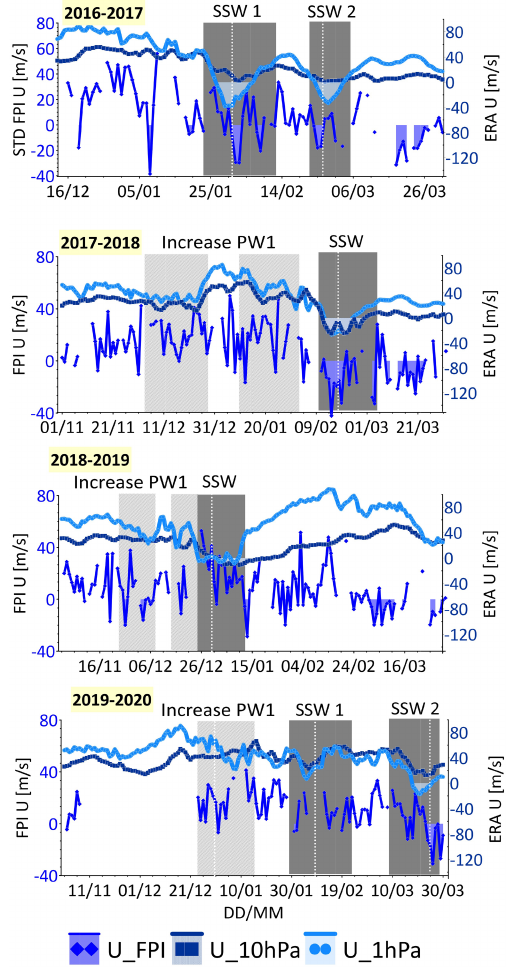
Figure 15. FPI-measured 557.7nm zonal wind (blue line), zonal mean zonal wind by ERA 5 at 10hPa (dark blue line) and at 1hPa (light blue line), the PW1 amplitude increase period (light grey rect- angle), the SSW periods (grey rectangle), and the day of the SSW maximal temperature (dotted white vertical line).